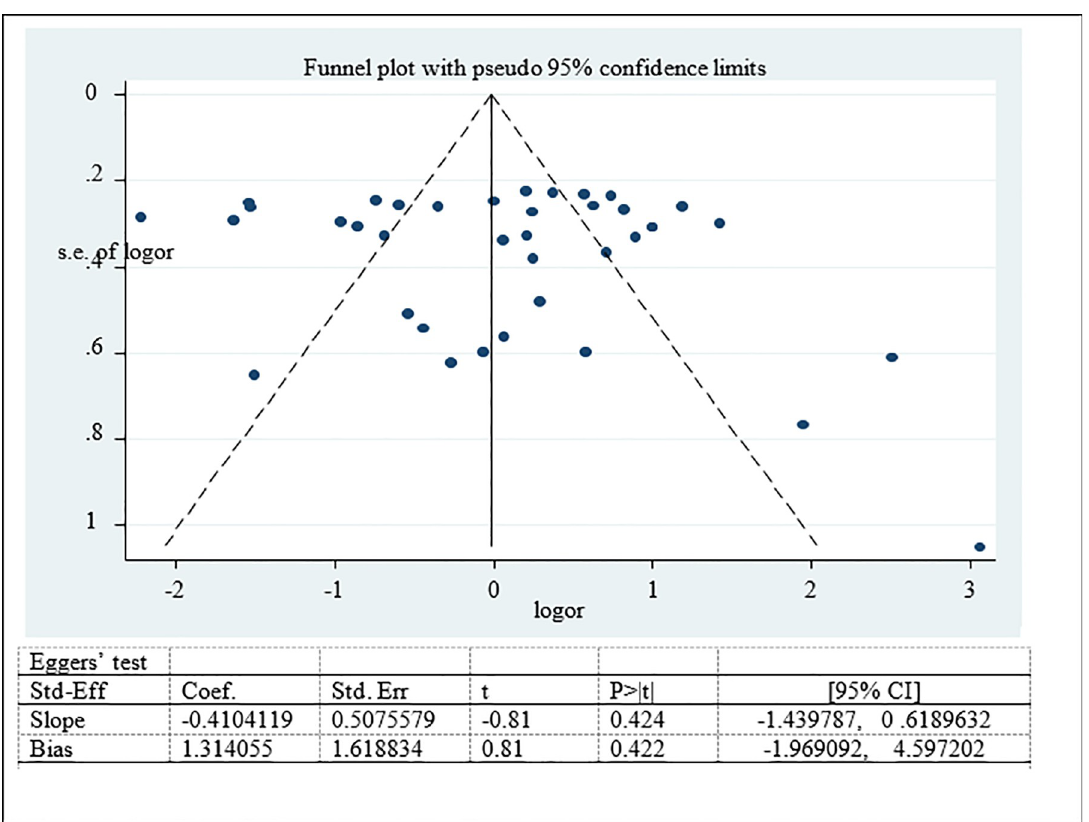
Fig 19. Funnel plot and Eggers’ test to assess publication bias for factor associated with adolescent overweight/obesity in Ethiopia.